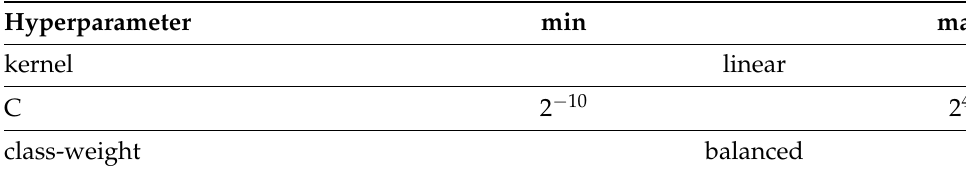
Table 3. Evaluated hyperparameters for the SVC with linear kernel.